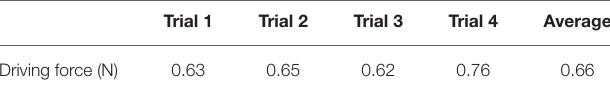
keeps closing while switching OFF, therefore the device does not consume energy to grab an